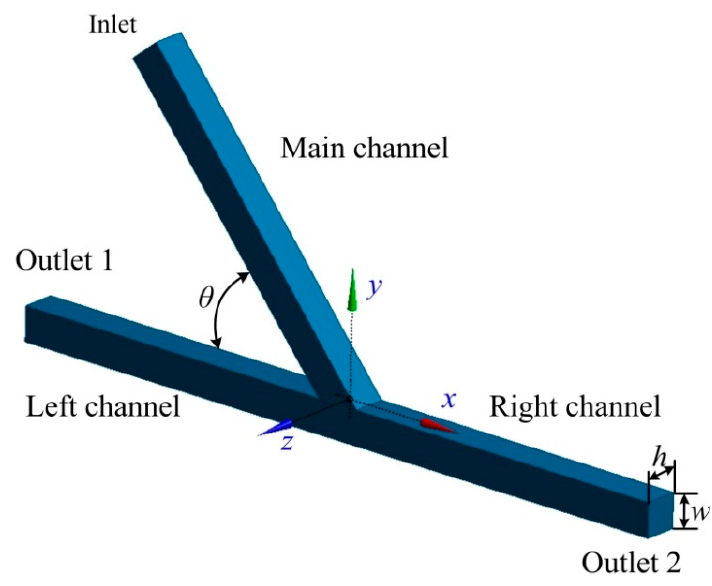
Figure 1. Geometry of the asymmetric acute junction.